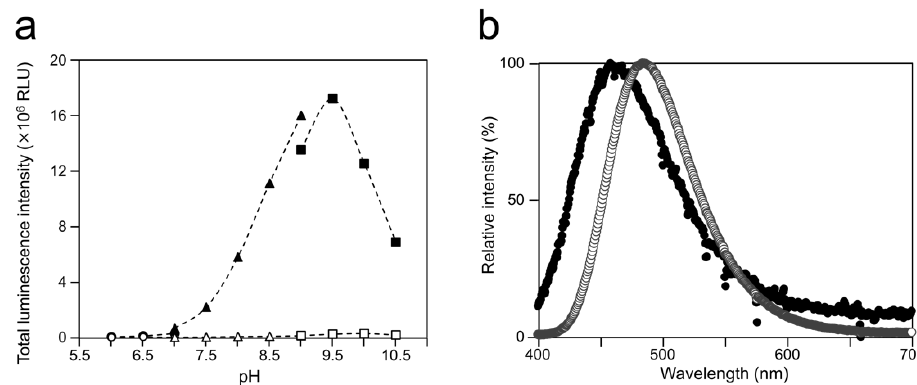
Figure 3. Optimum pH for luminescence of Cypridina luciferin with hAGP and spectra at the optimum pH: ( a ) luminescence of Cypridina luciferin in the presence of hAGP under various pH buffer conditions and ( b ) emission spectra in the presence of hAGP or a recombinant CLase from C. noctiluca in 50 mM Gly-NaOH (pH 9.5). In panel ( a ), closed circles represent 50 mM BisTris-HCl containing hAGP, open circles represent 50 mM BisTris-HCl, closed triangles represent 50 mM Tris-HCl containing hAGP, open triangles represent 50 mM Tris-HCl, closed squares represent 50 mM Gly-NaOH containing hAGP, and open squares represent 50 mM Gly-NaOH. The bars represent the mean values ± SD for n = 3. In panel ( b ), closed circles represent the presence of hAGP and open circles represent the presence of CLase.